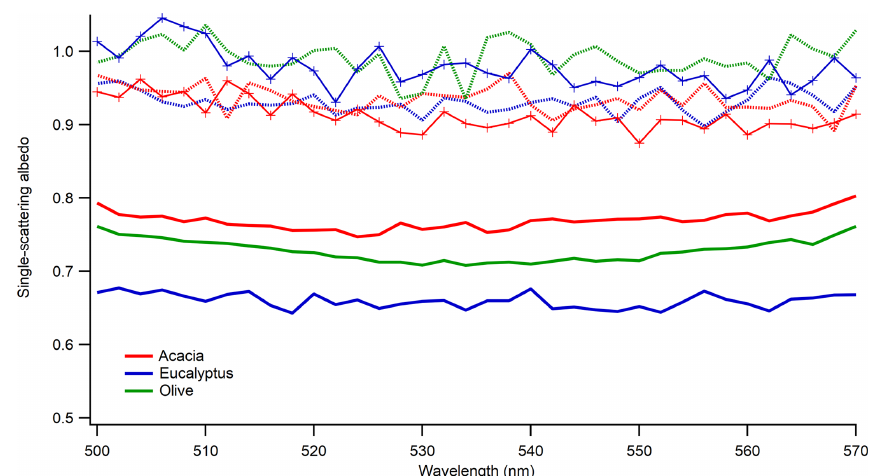
Figure 7. Impact of photochemical aging (light and light plus VOCs) on SSA of 300nm size-selected smoldering-dominated aerosol. Solid lines are for freshly emitted particles, dotted lines are for aging under the light, and solid lines with symbols are for aging under light plus VOCs. Different colors are for the different fuels listed in the